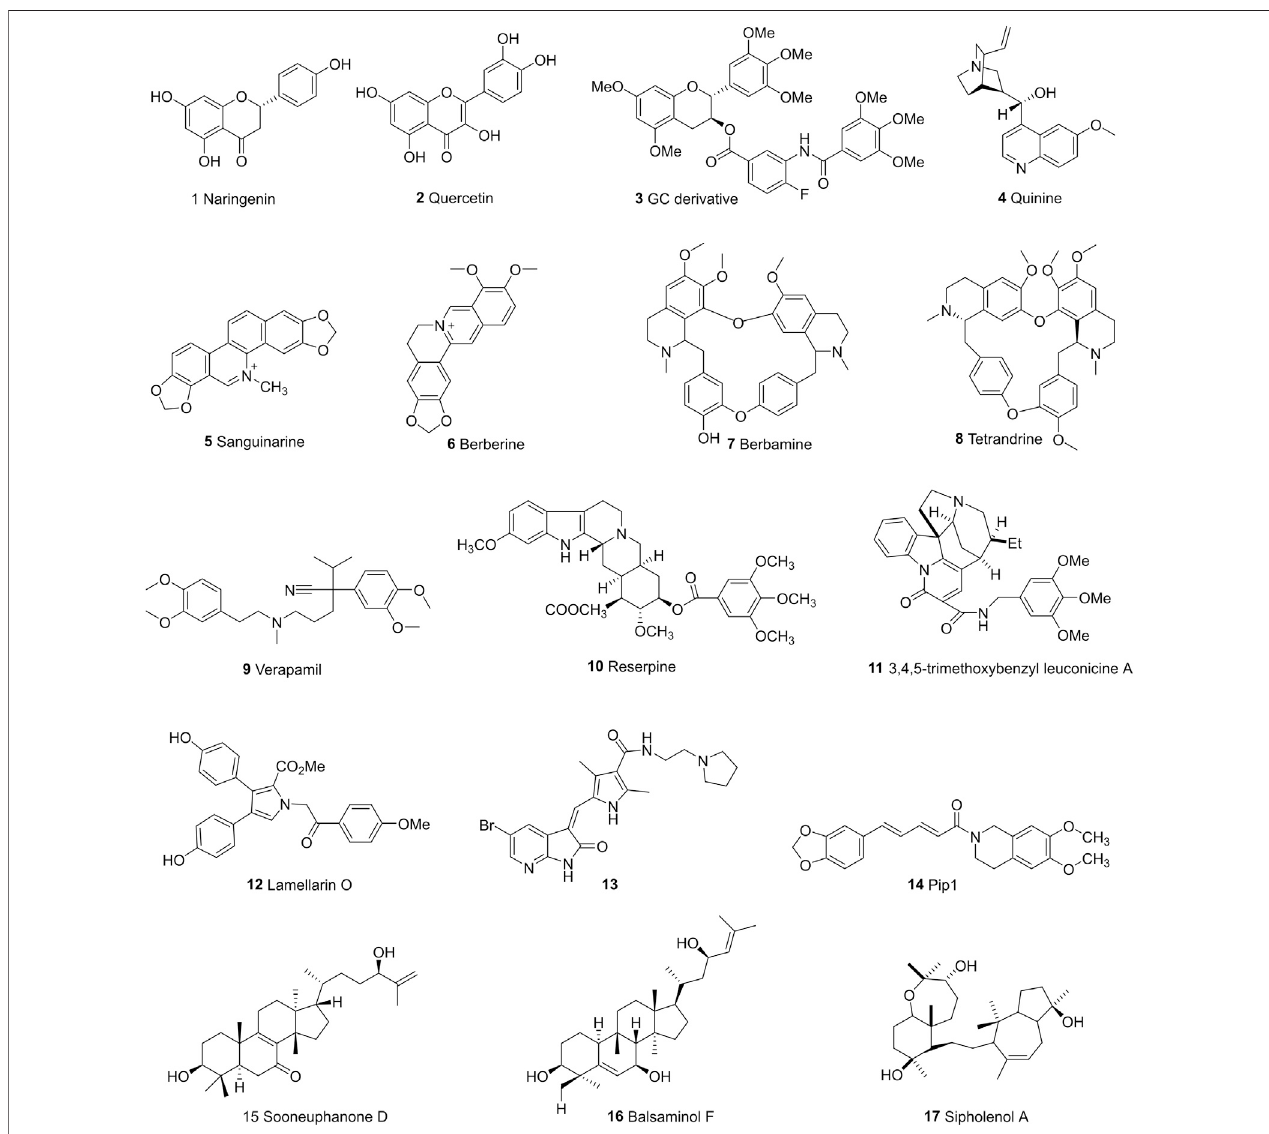
FIGURE 4 | The chemical structures of representative P-gp